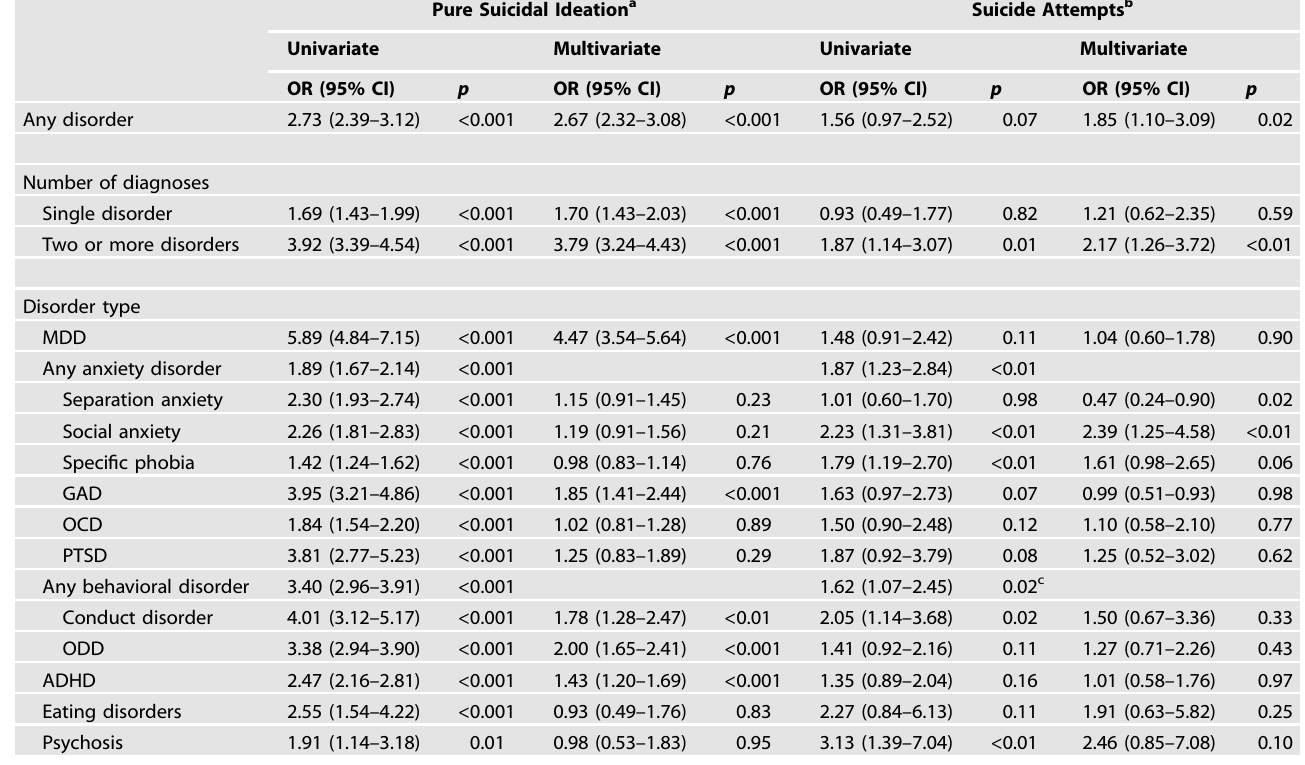
Table 3. Diagnostic predictors of suicidal ideation and suicide